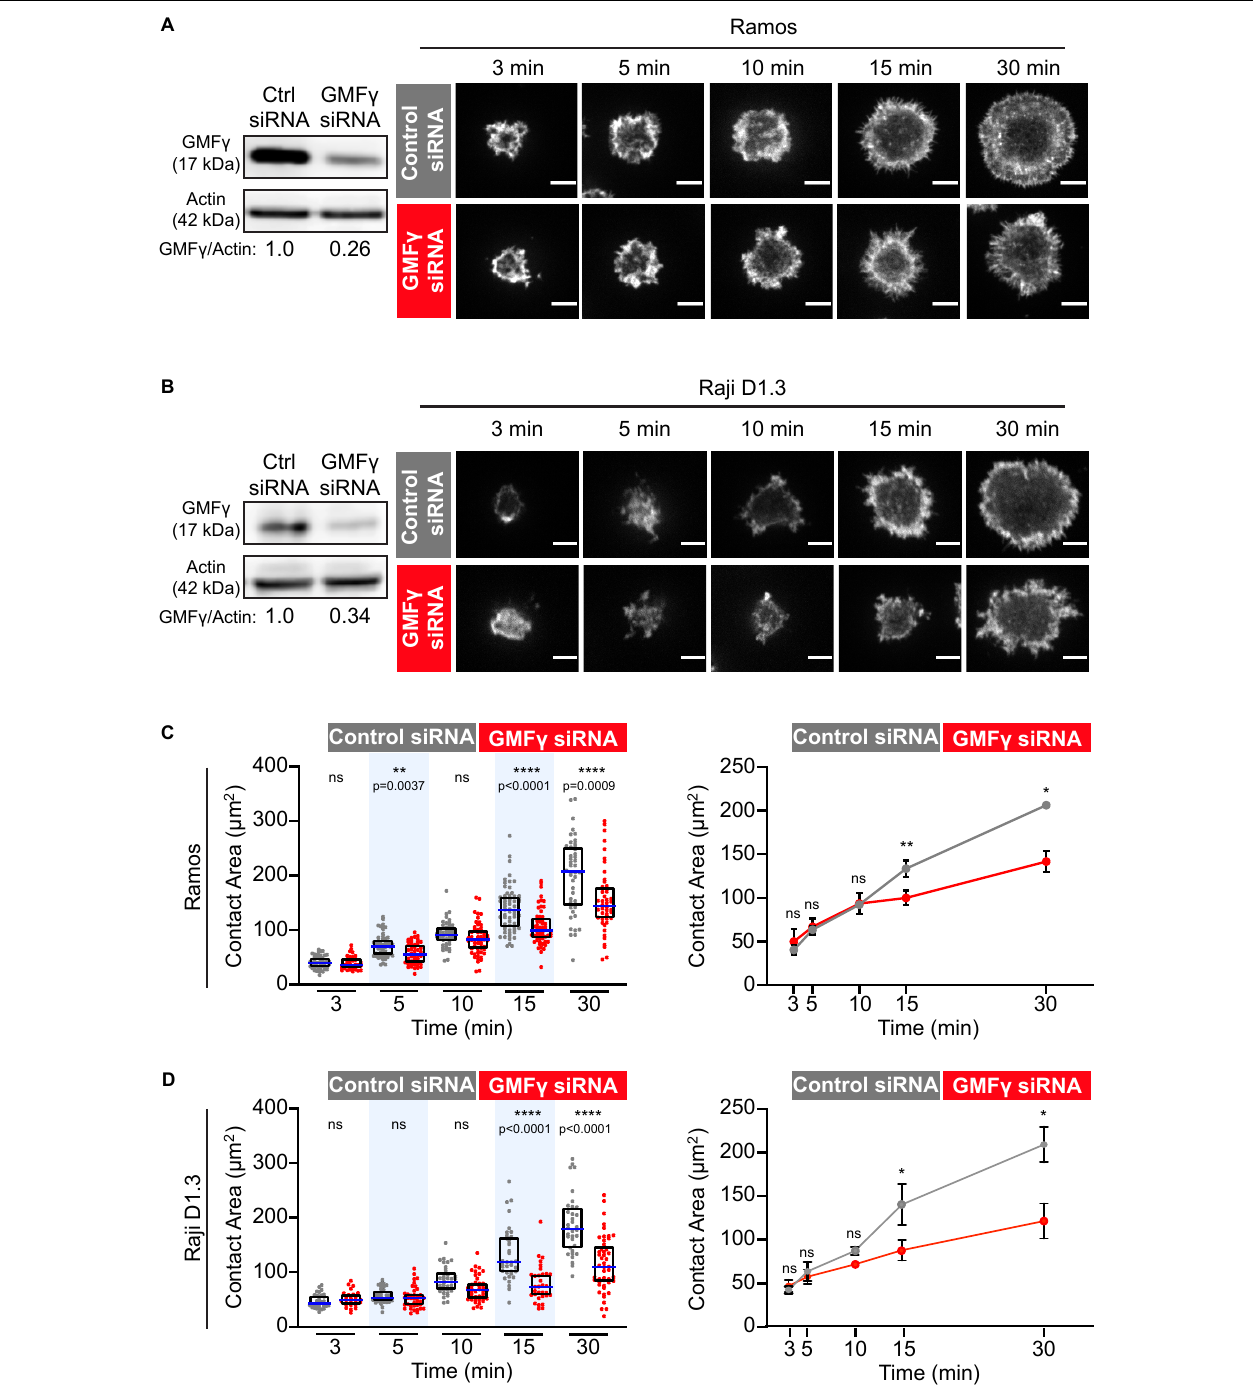
FIGURE 1 | Depleting GMF γ reduces B cell spreading on immobilized anti-Ig. (A,B) Ramos B cells (A) or Raji D1.3 B cells (B) were transfected with control non-targeting siRNA or GMF γ siRNA. Immunoblots (left panels) show GMF γ levels in cell extracts, with actin as a loading control. The transfected B cells were added to anti-IgM-coated-coverslips and allowed to spread for the indicated times before being stained with rhodamine-phalloidin. Representative confocal microscopy images are shown (right panels). Scale bars: 5 µ m. (C,D) For each B cell, the cell area was quantified using the actin staining to define the cell edge. The left panels show data from representative experiments. Each dot represents one cell. The median (blue line) and interquartile ranges (black box) for > 30 cells are shown for each time point. p -values were determined using the Mann-Whitney U -test. The right panels show the mean ± SEM of the median cell areas from three independent experiments. Where no error bars are shown, they were smaller than the symbols. p -values were determined using paired two-tailed t -tests. **** p < 0.0001; ** p < 0.01; * p < 0.05; ns, not significant ( p > 0.05).